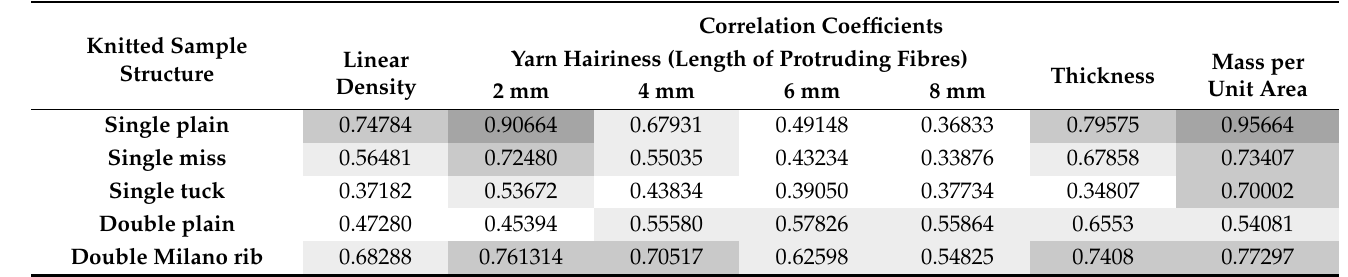
Table 10. The correlation coefficients between water vapour resistance and selected yarn and fab- ric properties.